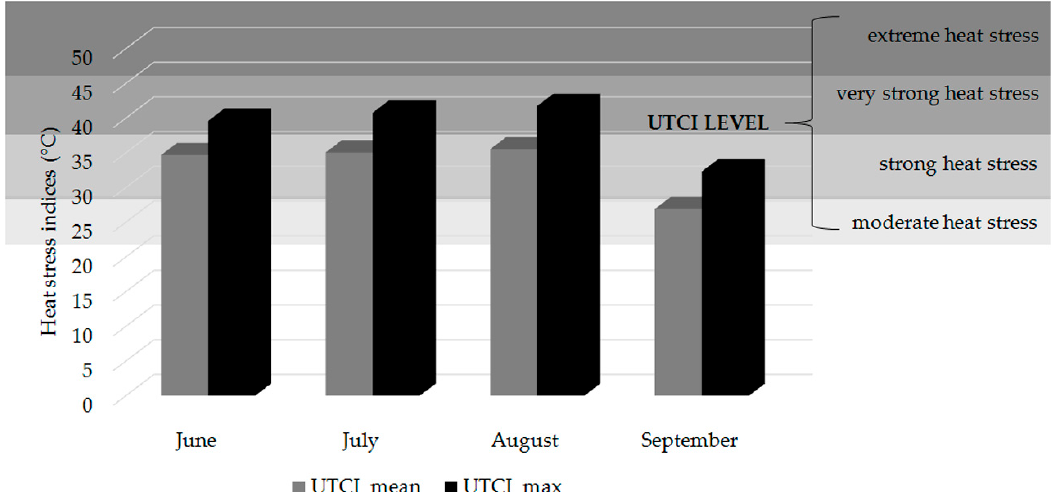
Figure 2. Mean and Maximum Universal Thermal Climate Index (UTCI) index for each month during the working time at the three work sites involved in the study (summer 2017) and the recommended rest according to the WBGT ISO standard for a worker that perform an activity that requires an effort of 300 watt. The bands of different shades of gray indicate instead the heat stress thresholds according to the Universal Thermal Climate Index (UTCI).